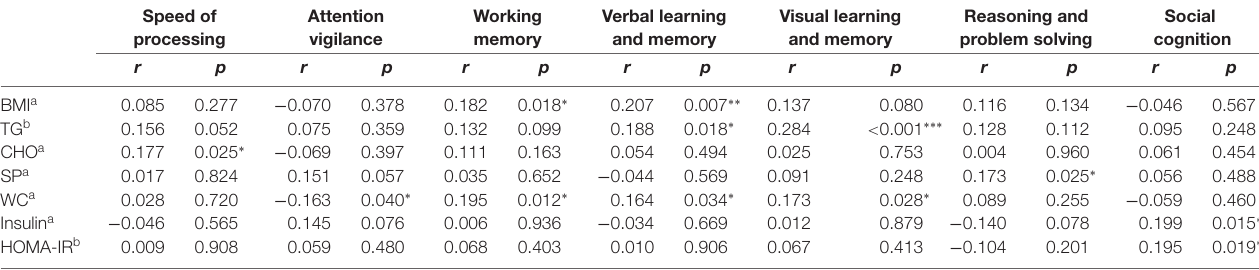
TABLE 3 | Correlation analysis on metabolic parameters and cognitive scores in early-stage schizophrenia patients (part of all). Speed of Attention Working Verbal learning Visual learning Reasoning and Social processing vigilance memory and memory and memory problem